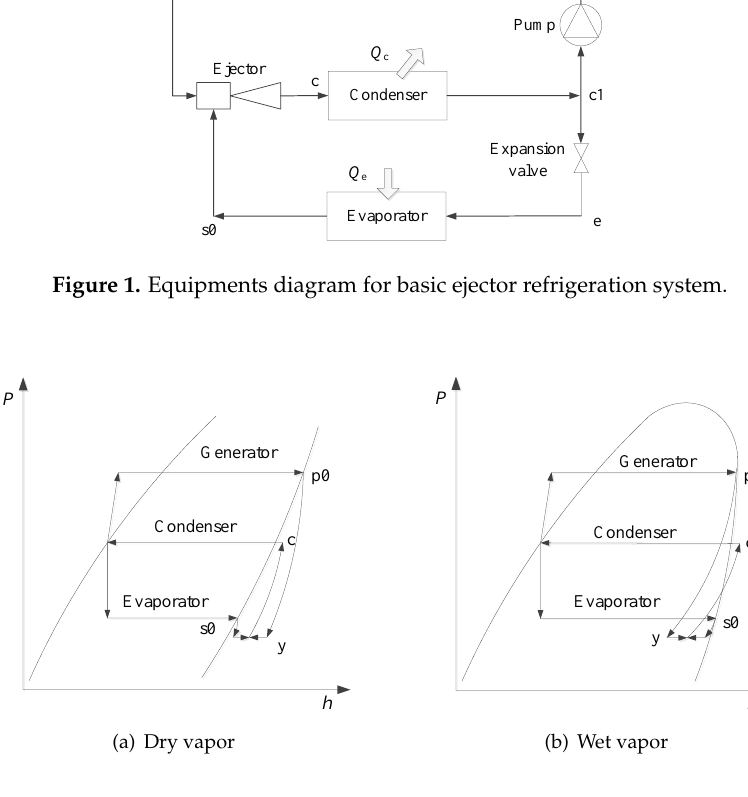
Figure 2. Pressure-enthalpy charts for ejector refrigeration cycles with dry and wet